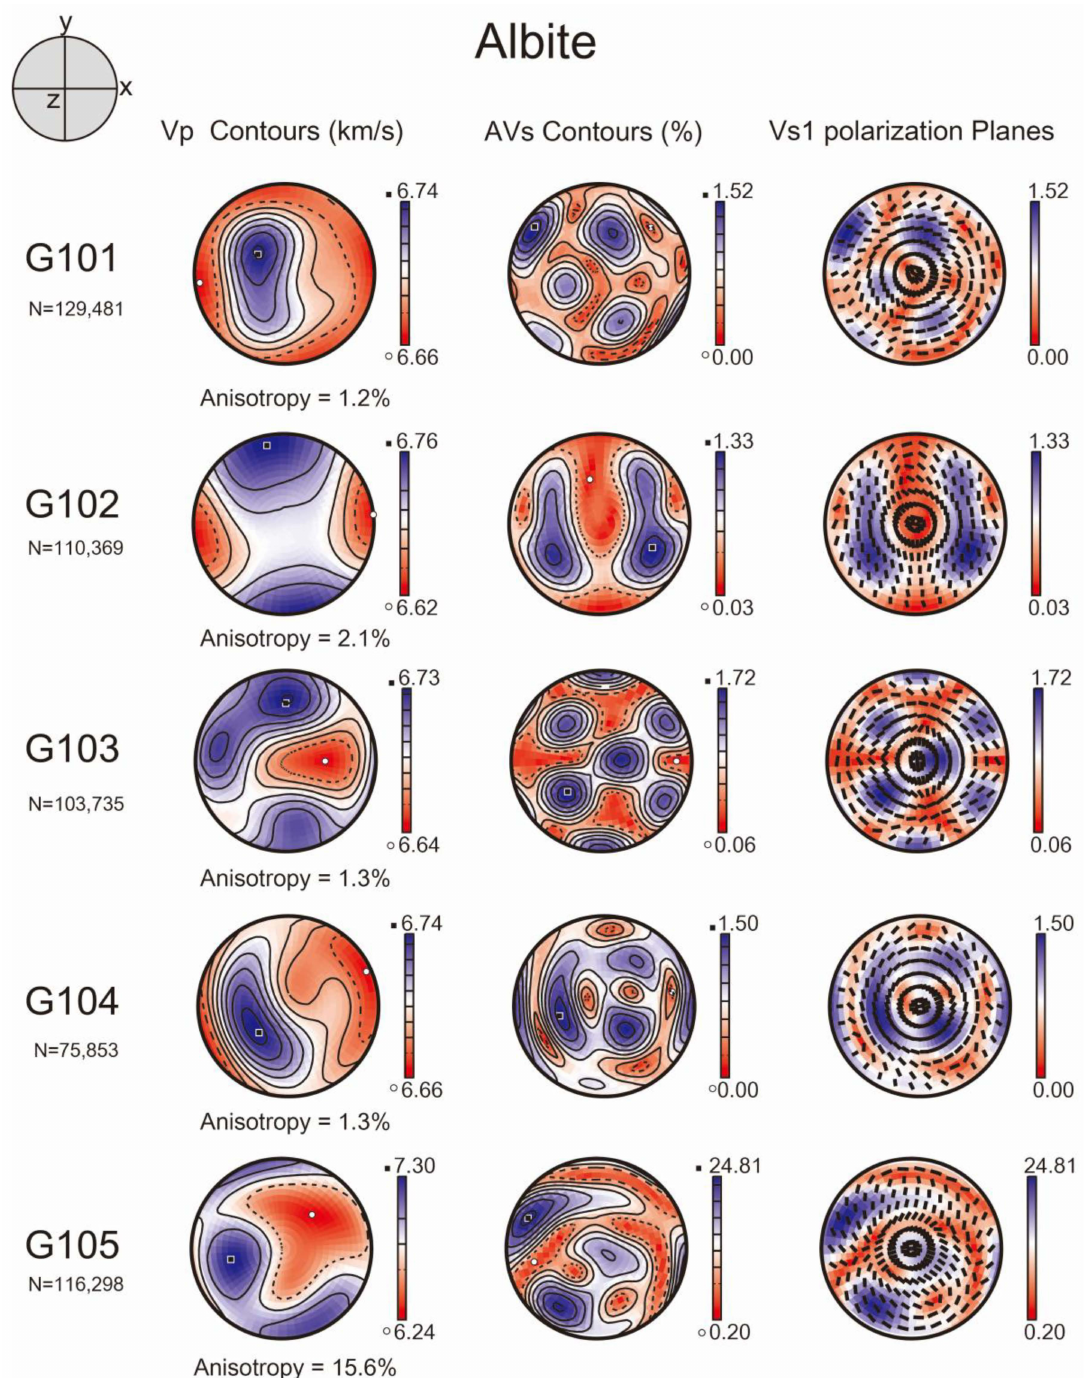
Figure 9. Seismic properties of albite calculated from LPO and elastic constant. The P-wave velocity (Vp), amplitude of the shear-wave anisotropy (AVs), and polarization direction of the faster shear wave (Vs1) are plotted in the lower hemisphere using an equal-area projection. E–W direction of each figure corresponds to stretching lineation (X), and Z is normal to the foliation. N = number of data